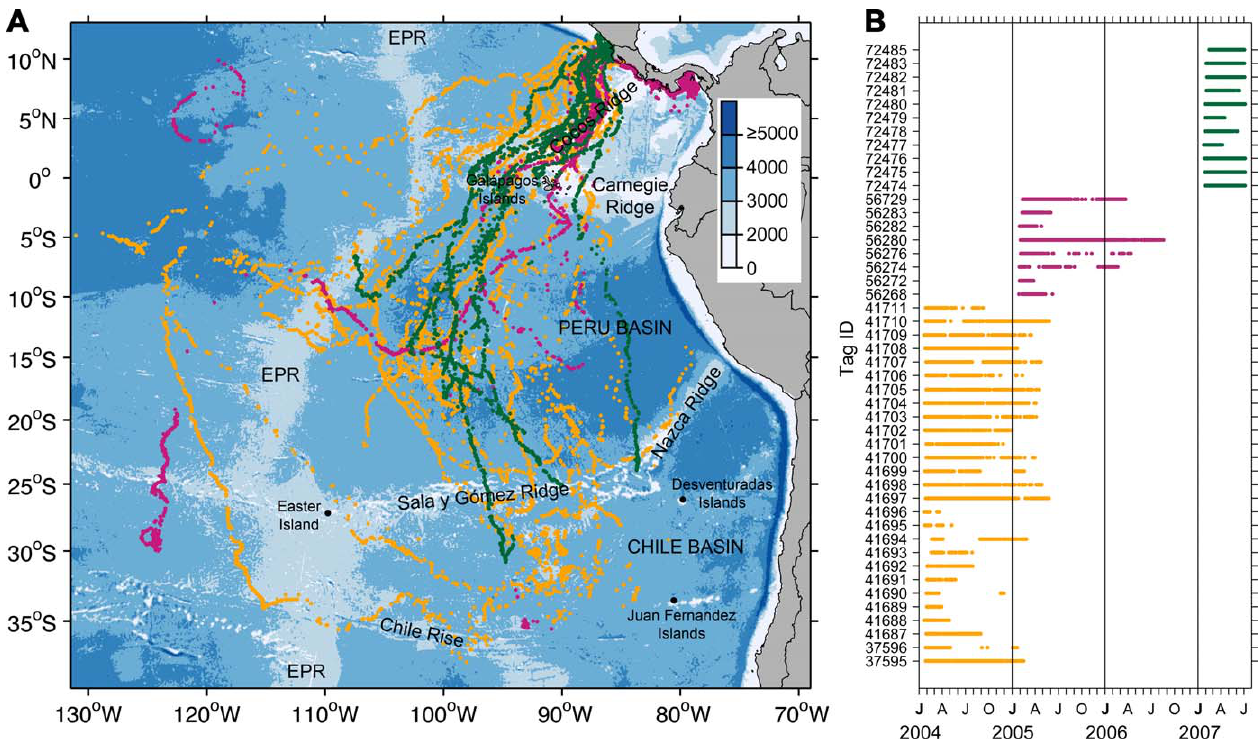
Figure 1. Map and Timeline of Leatherback Sea Turtle Tracking Data (A) Satellite transmission positions for 46 leatherback turtles from 2004 ( n ¼ 27, orange), 2005 ( n ¼ 8, purple), and 2007 ( n ¼ 11, green), tagged at Playa Grande, Costa Rica, overlaid on bathymetry (in m). Prominent bathymetric features and island groups are labeled (EPR ¼ East Pacific Rise). (B) Timeline of satellite transmissions for each tag (tag ID is the ARGOS-assigned transmitter number).